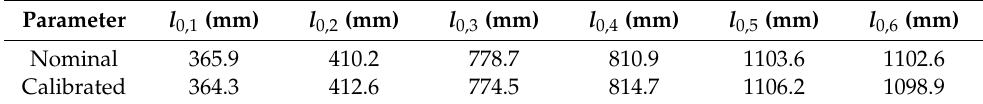
Figure 6. Measured motor positions for calibration and its nominal values. Table 2. Nominal and calibrated values of initial cable